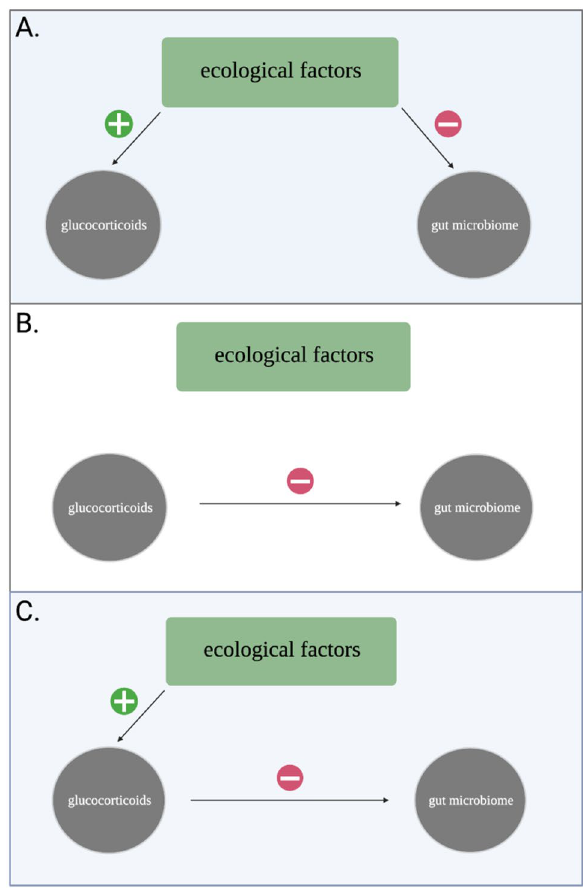
Figure 1. Conceptual model demonstrating how ecological factors structure the relationship between glucocorticoids and the gut microbiome. ( A ) Environmental covariance results in direct effects on both variables and diminishes a detectable effect of GCs on gut microbiome diversity. ( B ) Ecology does not influence either variable and a direct effect of GCs on gut microbiome diversity is preserved. ( C ) Ecological factors influence gut microbiome diversity indirectly via host GCs. Note that the three scenarios are not mutually exclusive, such that a combination of direct ( A ) and indirect ( B ) effects may result in the appearance or absence of a relationship between GCs and gut microbiome diversity.